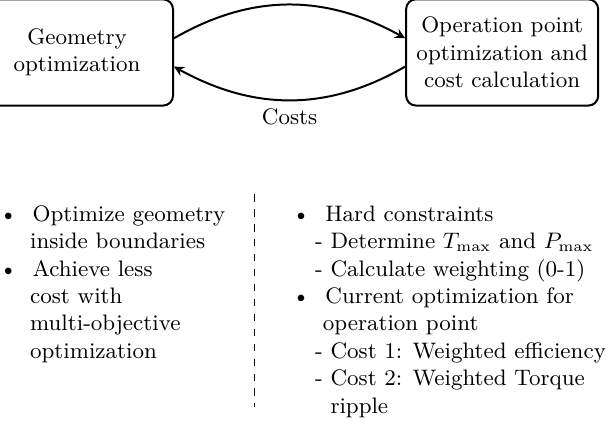
Figure 8. Overview of the nested optimization.